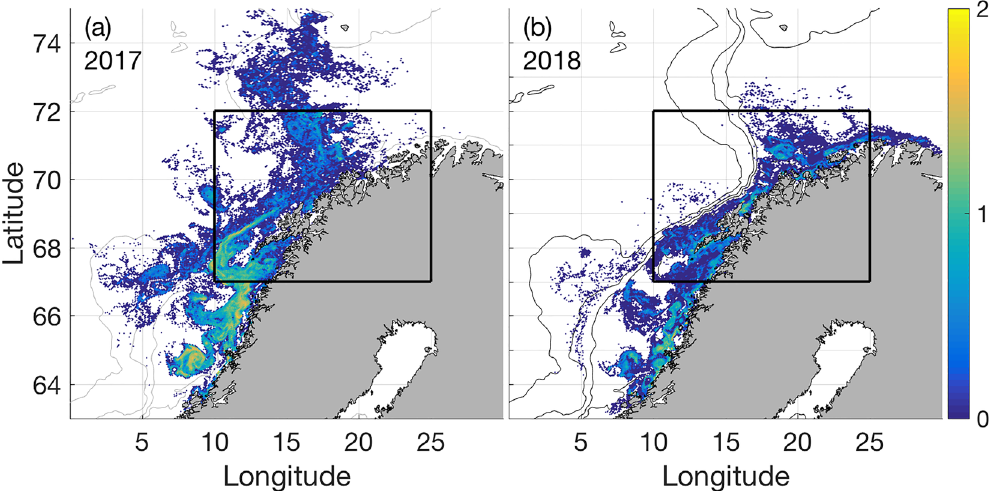
Figure 1. Modelled NSS herring larvae distribution, (abundance = log n) ( a ) 2017 and ( b ) 2018 based on an individual-based particle drift model initiating particles at the time of hatching between March 15th until April 20th at well-known spawning grounds but mainly at Møre (about 63° N).